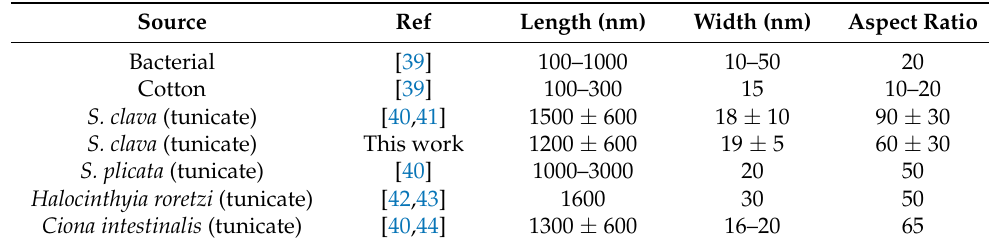
Table 1. Characteristics of the cellulose nanocrystals from different sources compared to this